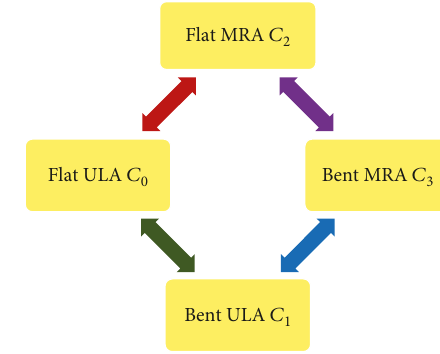
Figure 15: Polar pattern of bent MRA.